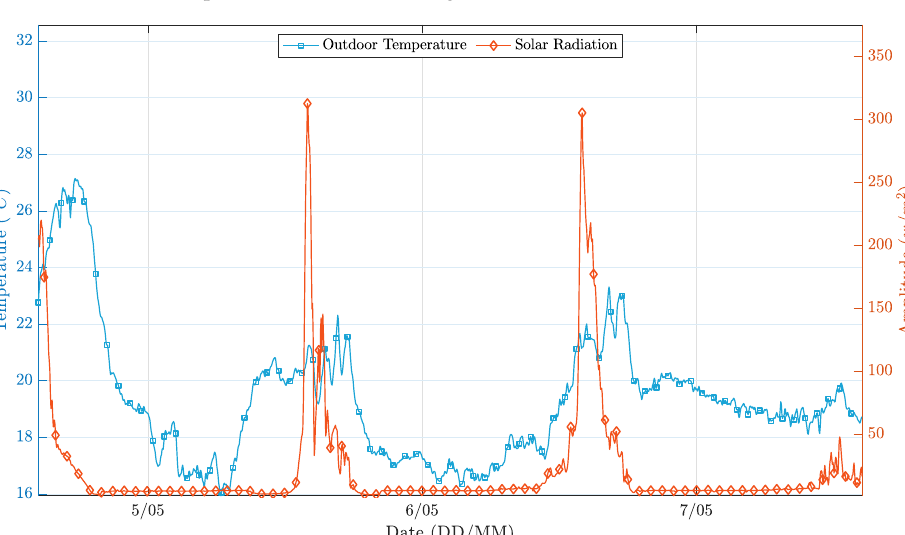
Figure 11. External environment conditions during test time on-off